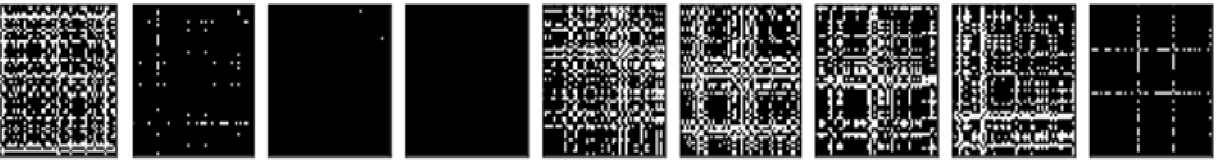
Figure 10. Recurrence plots for nine-time series of bearing vibration signals with different health conditions.